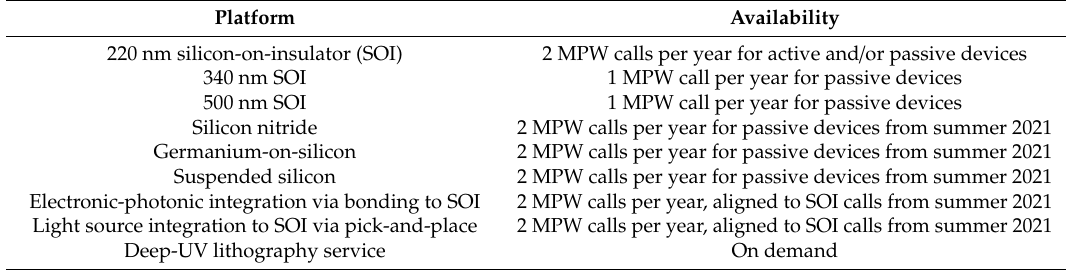
Table 1. Summary of CORNERSTONE rapid prototyping capabilities with approximate availability, which is subject to change. Bespoke fabrication batches are also available for all platforms on